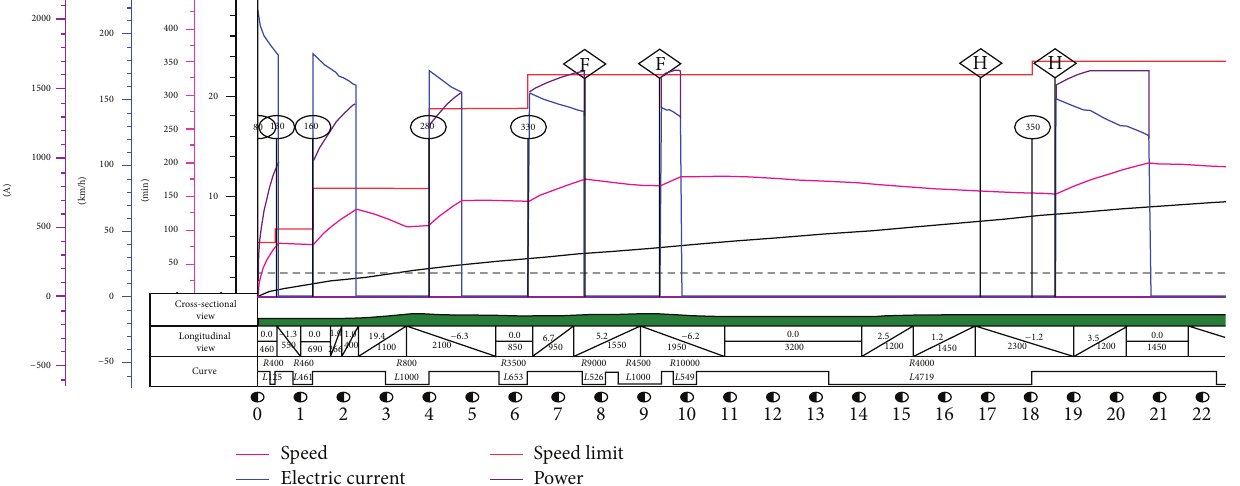
Figure 6: Result of normal specified time running strategy.